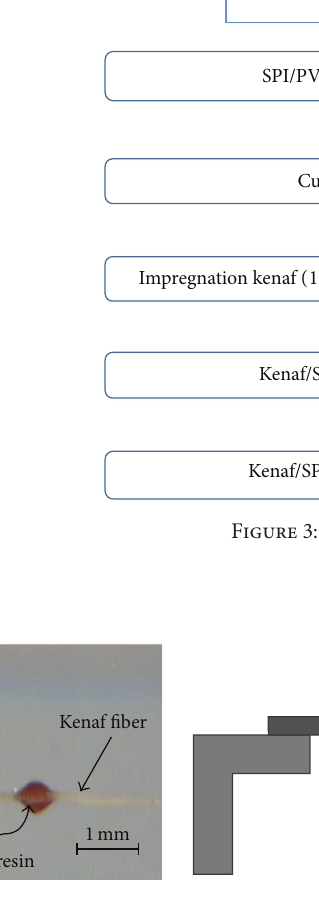
Figure 4: Photograph and schematic diagram of the microdroplet debonding test sample and test setup.